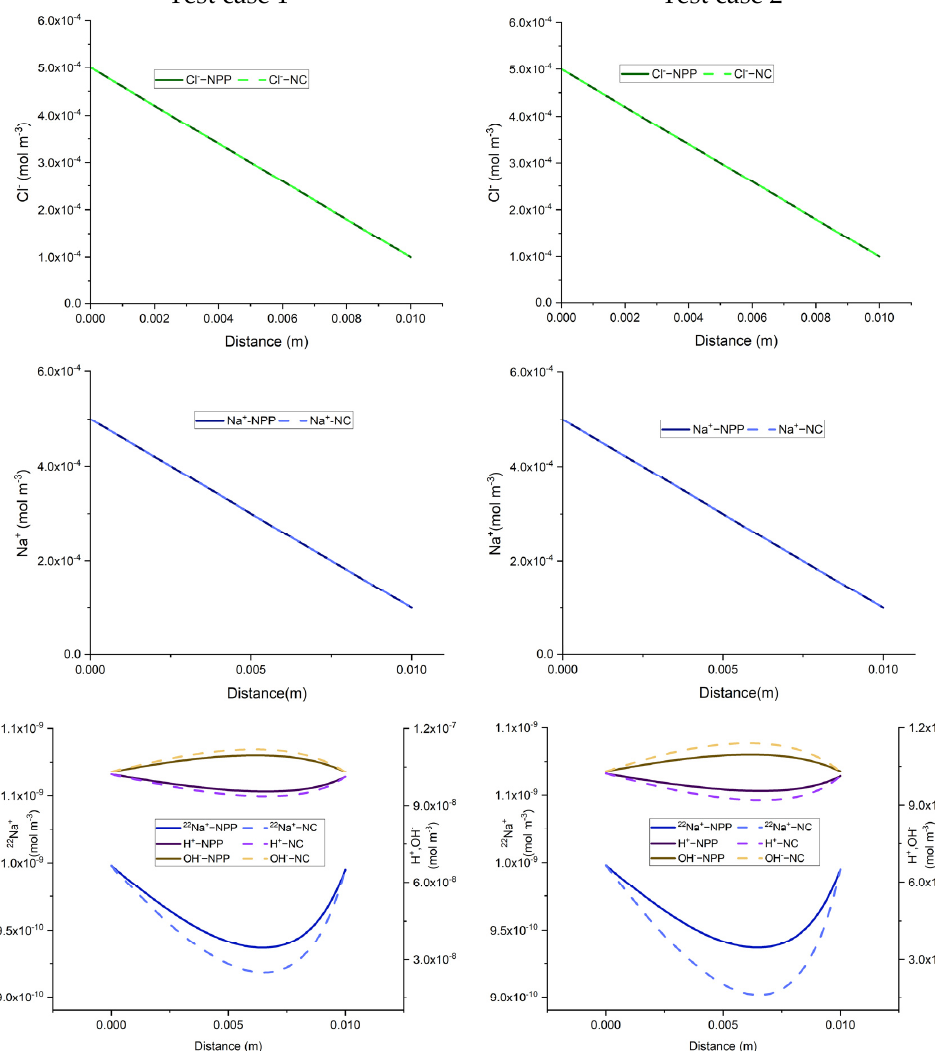
Figure 5. Comparison of total concentration results of the NPP and NC models for Benchmark 2 with linear initial condition Figure 1.— left ), high sorptivity (test case 2— right